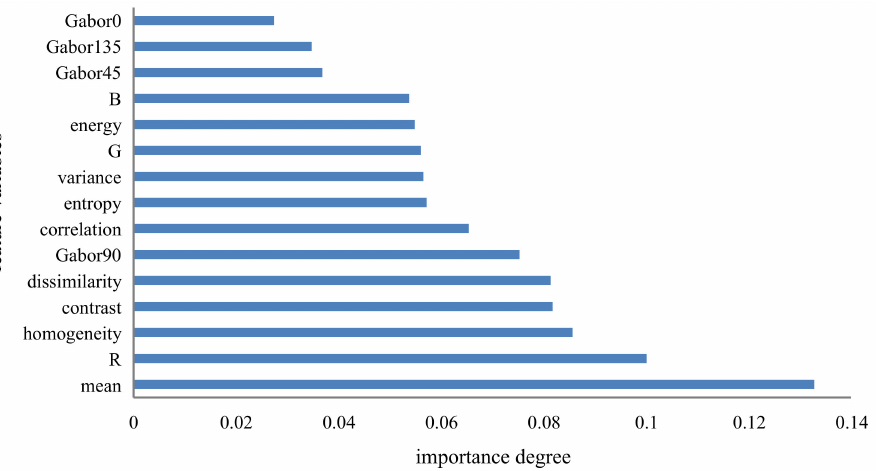
Figure 6. The importance of feature variables obtained through the random forest model.